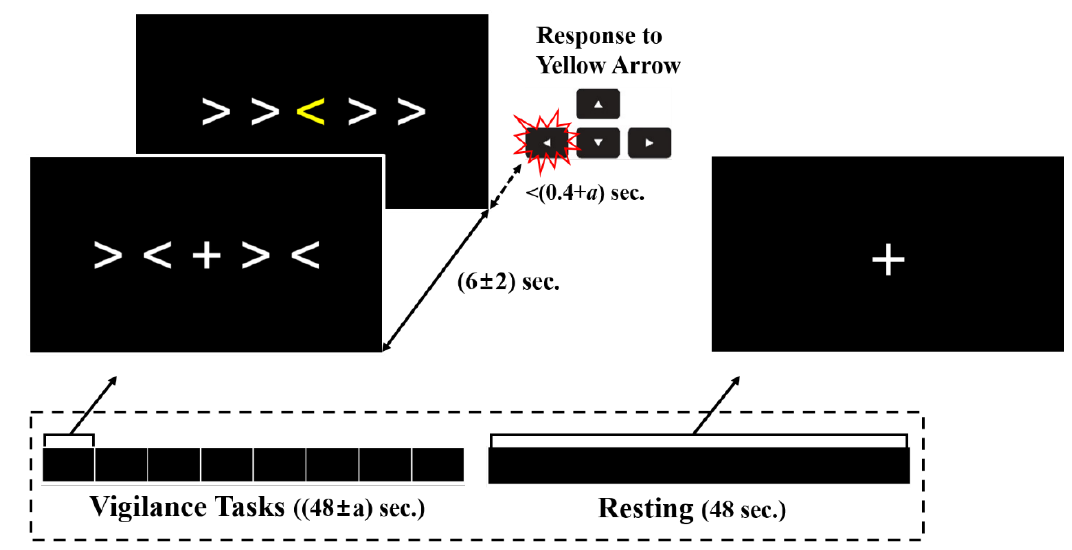
Figure 2. The task for eliciting the attention and resting states. The upper left inset shows the paradigms of the visual vigilance tasks; the target cue centered on the monitor (yellow arrow) was randomly presented with congruent or incongruent flankers. Participants were to press the arrow key corresponding to the target cue as quickly as possible, regardless of the flankers. After 8 trials of vigilance tasks, the participants rested for 48 s while trying not to move.